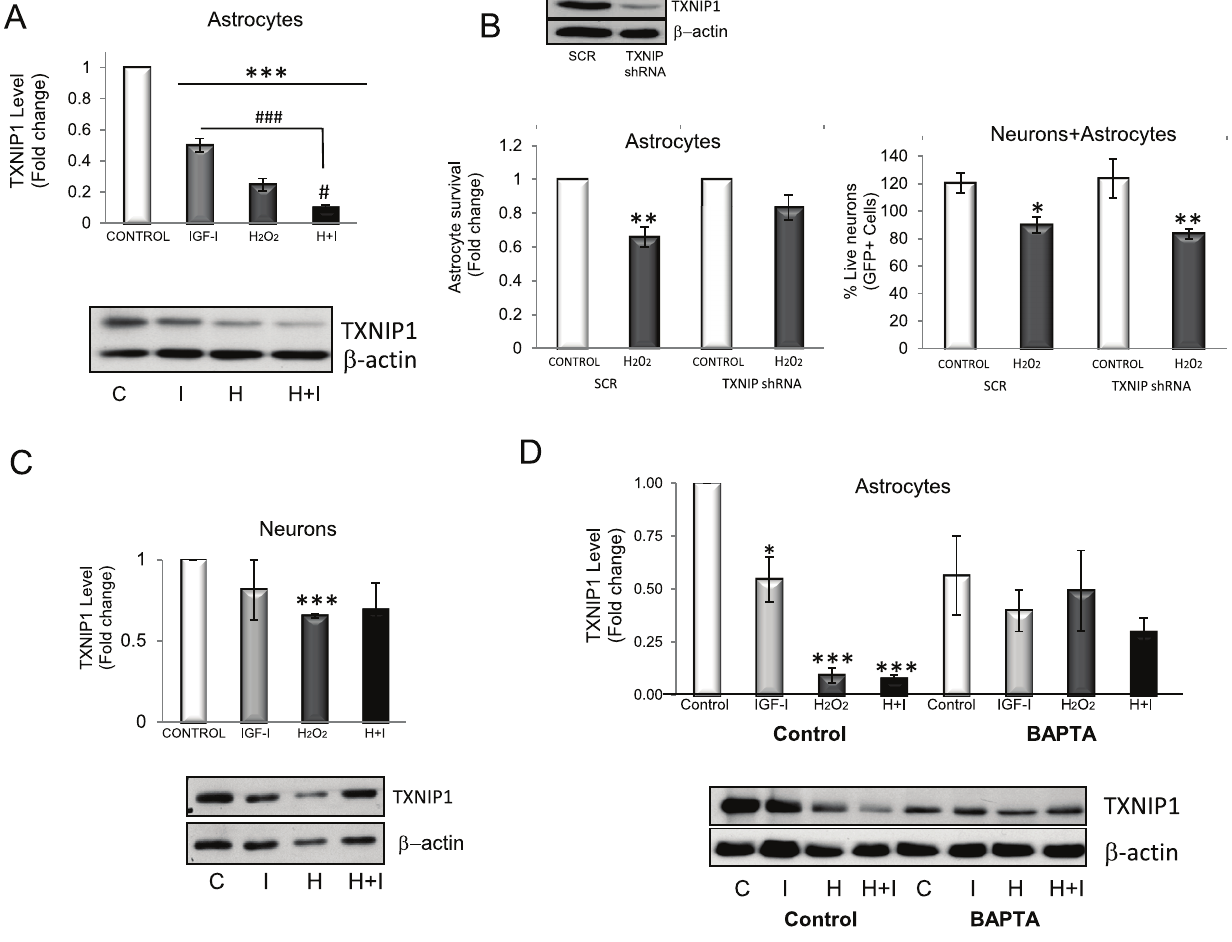
Figure 6. Both H O and IGF-I reduce TXNIP1 in astrocytes. A ) Levels of the pro-oxidant protein TXNIP1 are reduced by IGF-I and H 2 2 Inhibition is greater when both are added together (F=156.6; ***p<0.001 vs. control and ###p<0.001 (vs. IGF-I) and #p<0.05 (vs. H of actin in each sample were measured to normalize TXNIP1 levels. B ) Western blot: transfection of astrocytes with shRNA TXNIP1 results in reduced TXNIP1 levels as compared to astrocytes transfected with scrambled shRNA (SCR). Left panel: TXNIP1 shRNA silencing makes astrocytes less sensitive to H O toxicity. Astrocyte viability was measured by FDA in the presence of 200µM H 2 2 and H O interaction: F=2.94; TXNIP1 shRNA, F=2.94; H O , p<0.001, F=35.5; post-hoc: **p<0.01 vs control). Right panel: However, neuronal 2 2 2 2 viability is not increased by reduced TXNIP1 in astrocytes as neurons die in the same proportion after H